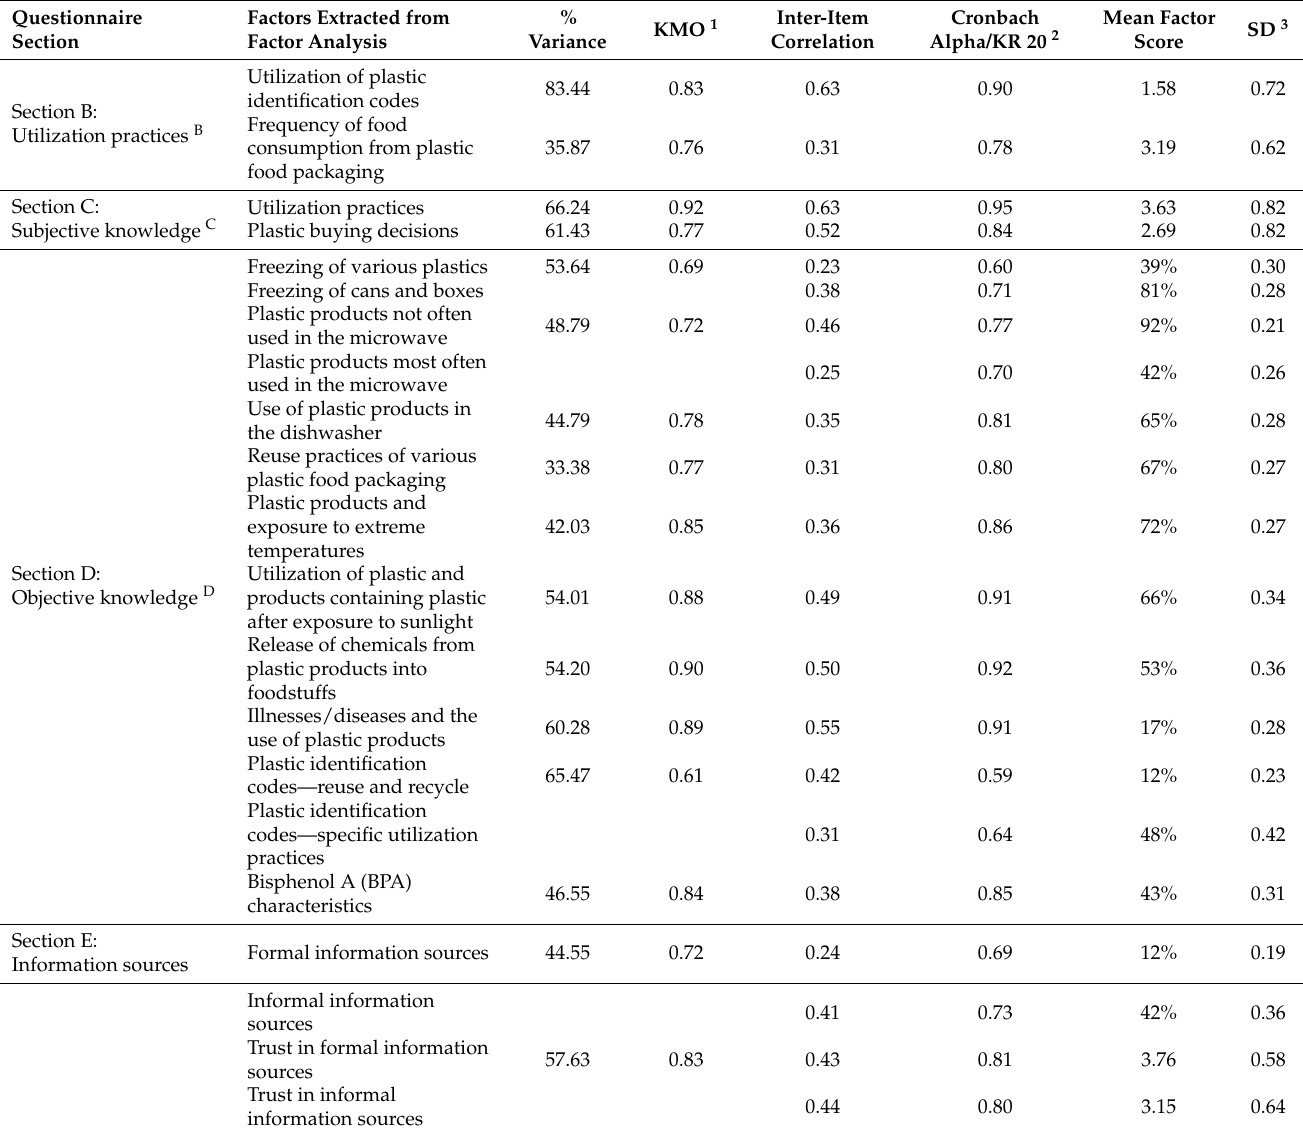
Table 3. Summary of the different factors extracted with exploratory factor